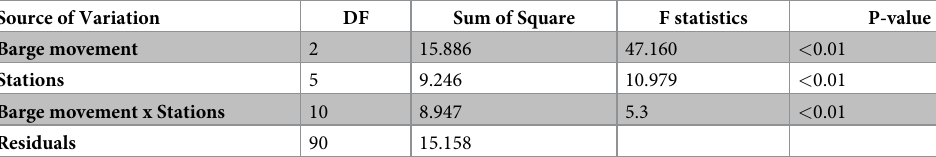
Table 6. Two way ANOVA shown combined effects of barge movement and phytoplankton biomass.